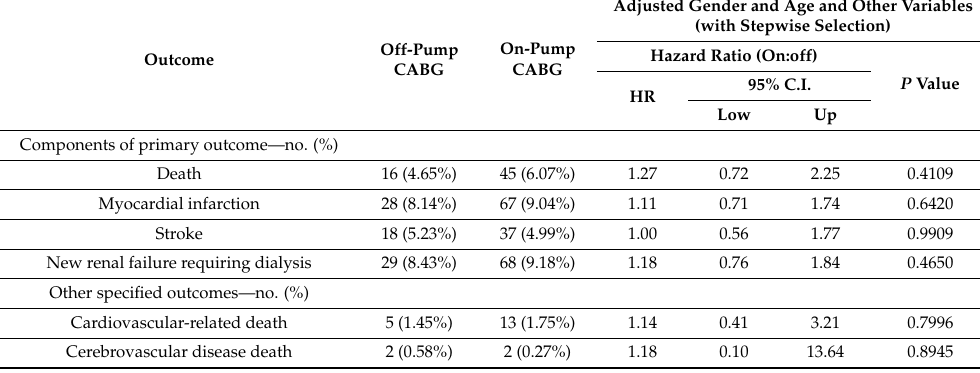
Table 4. Outcomes at 5 years.